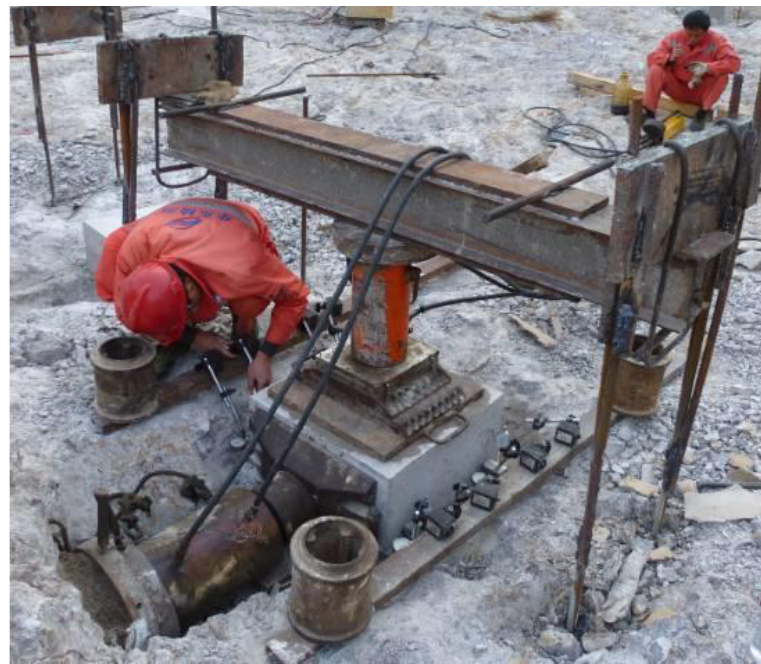
Figure 2. The in-situ direct shear test of the rock-concrete interface.